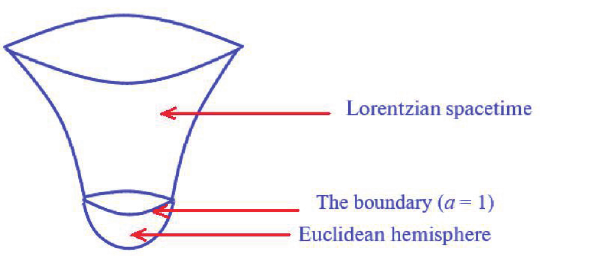
Figure 1. The physical continuum consisting of a Euclidean hemisphere glued to a Lorentzian spacetime on its boundary. The value of a scale factor a = 1 at the boundary (in the Planck units). Cf. Figure 1 in